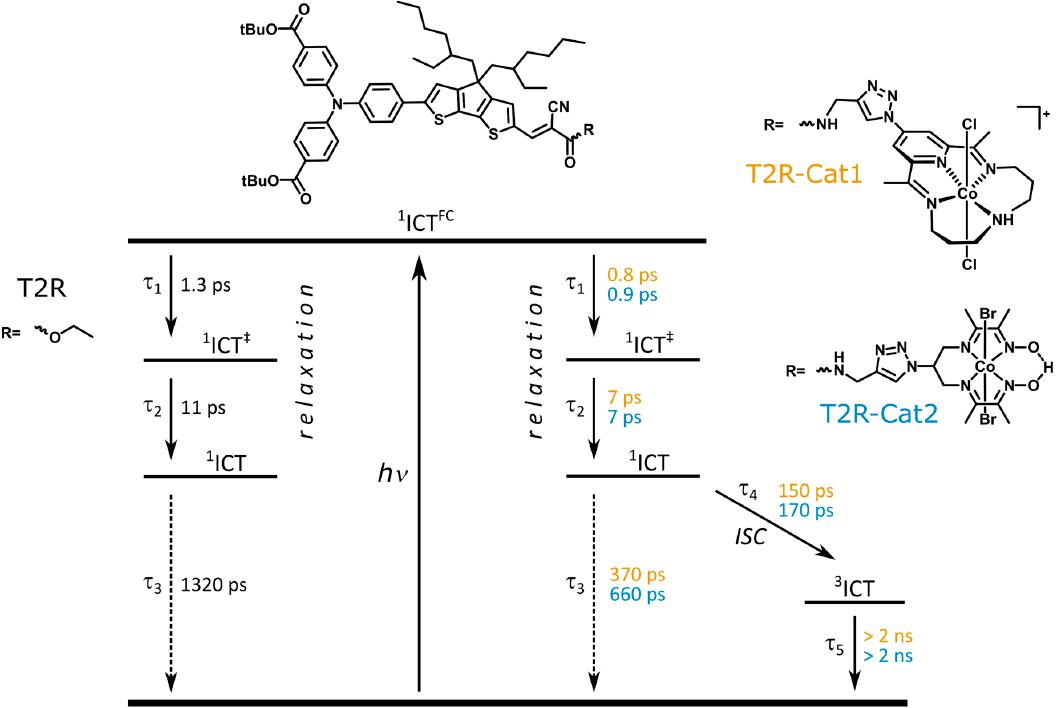
Figure 4. Photophysical model for the light-induced processes upon excitation at 480 nm. The pathway to the triplet state by ISC ( τ 4 ) is only open for the dyads. Dashed arrows indicate radiative transitions. Table 1. Characteristic time constants of light-induced processes upon excitation at 480 nm. The corresponding rates are given in Table S2.